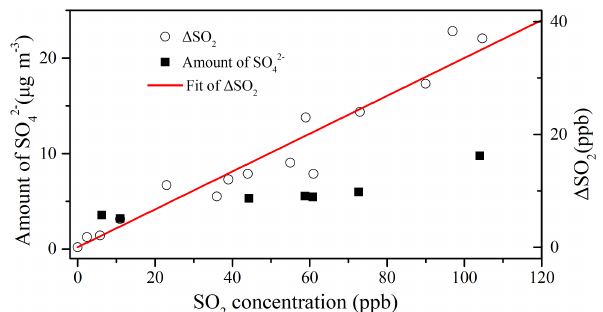
Figure 3. The amount of SO 2 − in particle phase and the consump- 4 tion of SO 2 ( (cid:49) SO 2 ) with different initial SO 2